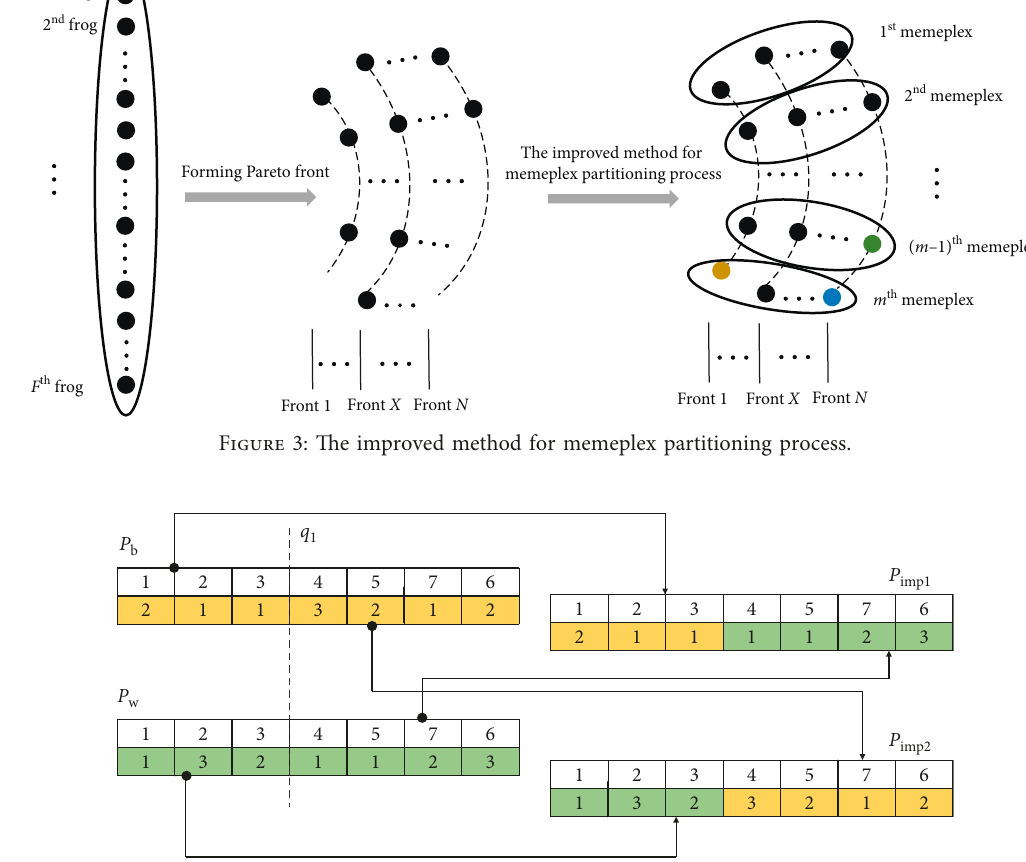
Figure 4: The adaptive memetic evolution method.